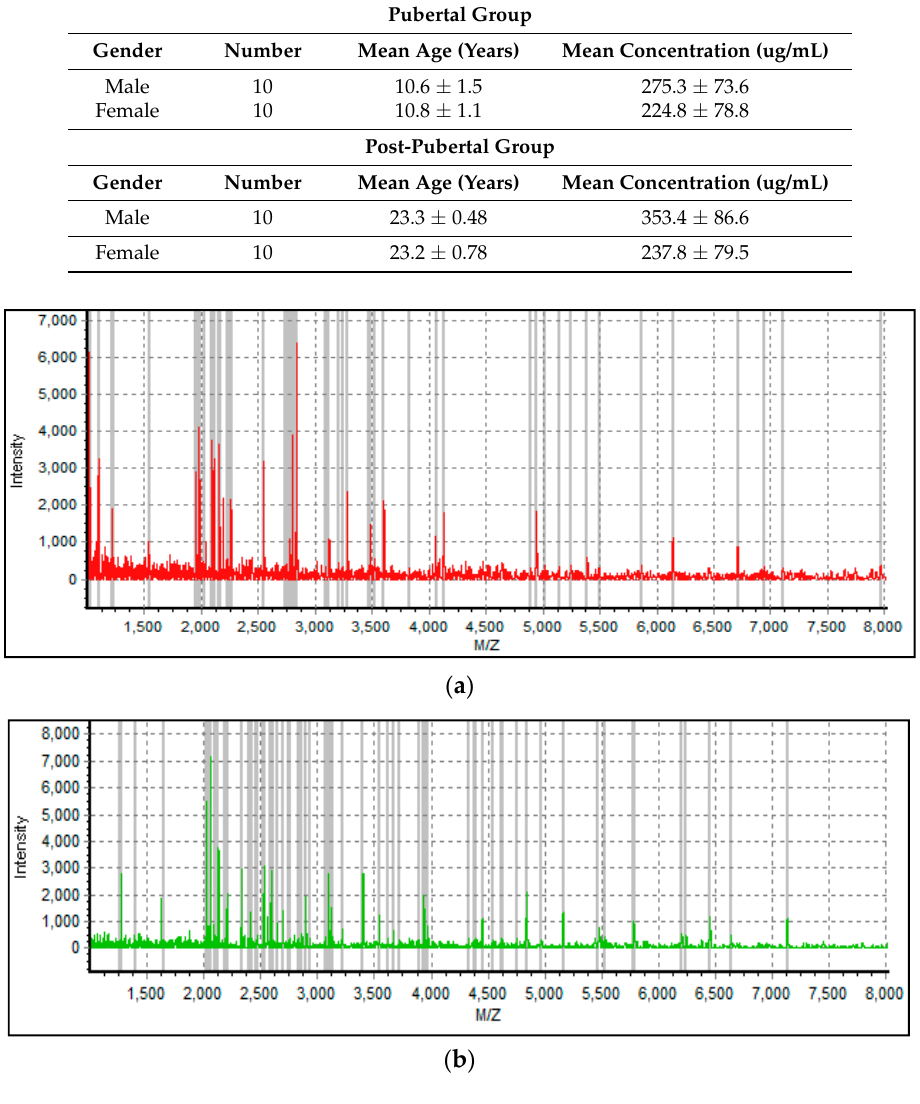
Figure 1. Matrix-assisted laser desorption/ionization time-of-flight mass spectrometry (MALDI-TOF/MS) profiles of gingival crevicular fluid (GCF) from individuals in the pubertal group ( a ) and the post-pubertal group ( b ).